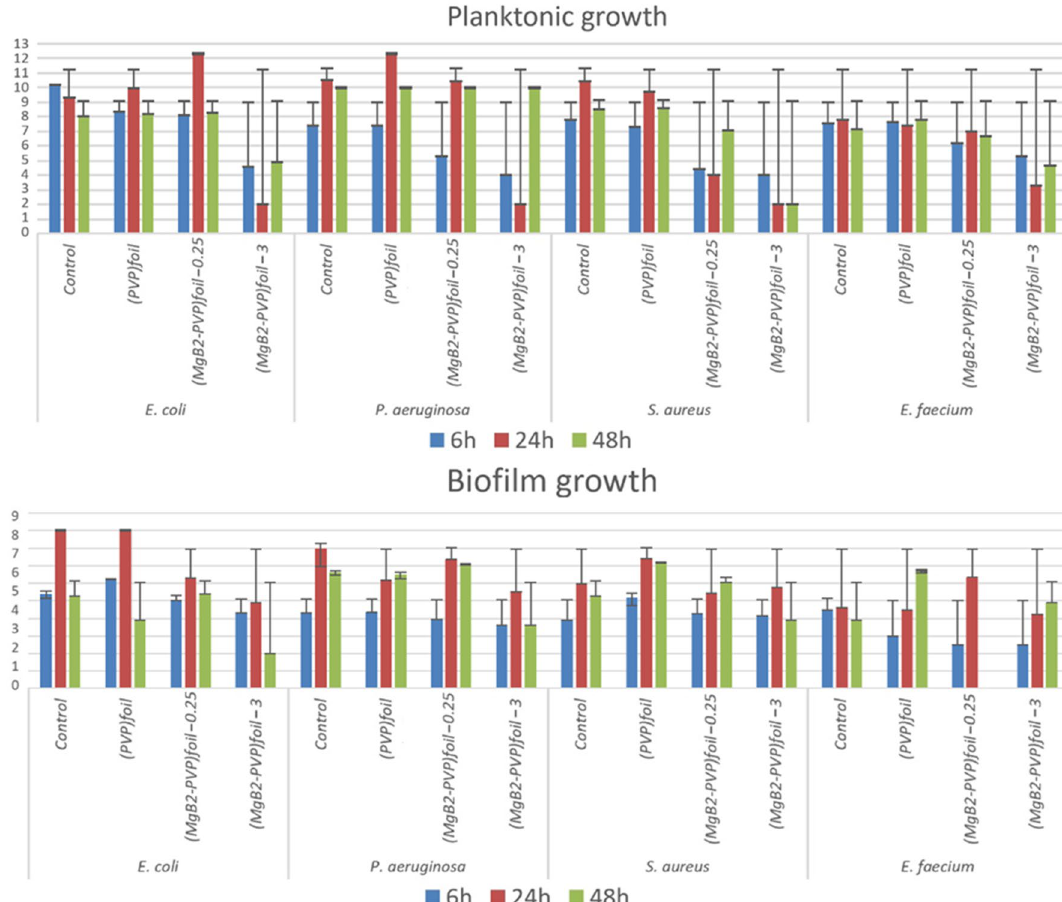
Figure 5. The number of viable microbial cells in log 10 (CFU/ml) for samples in the form of coatings on the plastic foil (i.e. samples PVP foil , (MgB 2 -PVP) foil 0.25 , (MgB 2 -PVP) foil 3 ) tested with microbes in plaktonic and biofilm growth